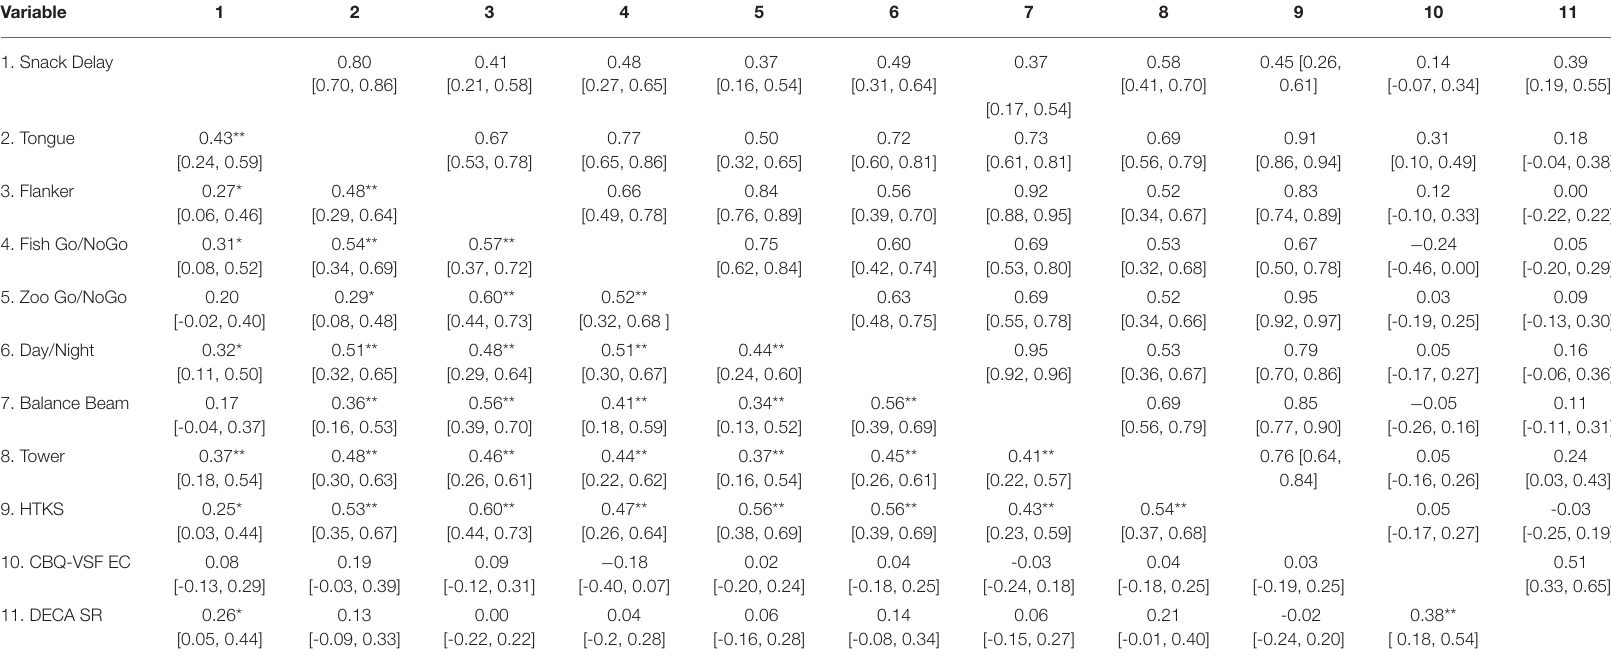
TABLE 3 | Correlations among self-regulation